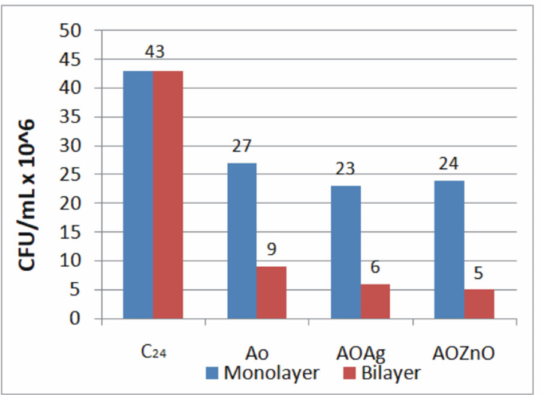
Figure 9. Evolution of Colony Forming Units Concentration in the presence of the mono- or bi- layered